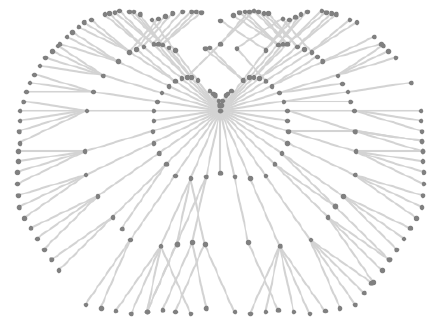
Figure 5. An example of isochrone points with edges to trace back the optimal